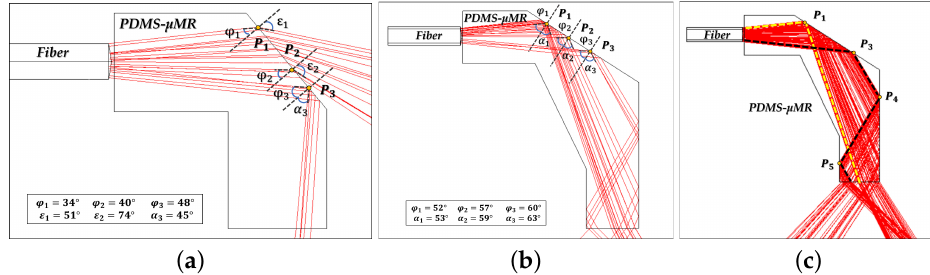
Figure 2. Optimal values of { β , γ } identified by ray tracing simulations. ( a ) The design of PDMS- µ MR with the surface M 1 angled by { β = 45 ◦ } . ( b ) The design of PDMS- µ MR including both surfaces { M 1, M 2 } angled by { β = 57.35 ◦ , γ = 26 ◦ } . ( c ) Complete path of the rays inside the PDMS- µ MR